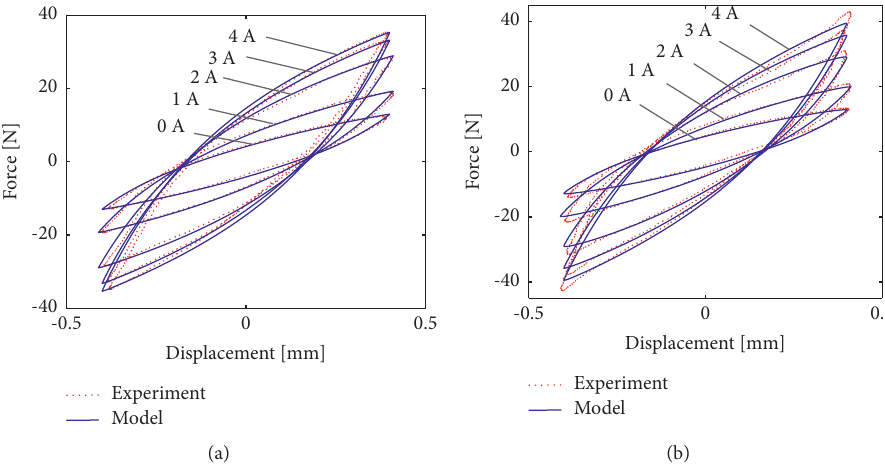
Figure 5: Force-displacement response under various applied currents ( I � 0A (0mT), 1A (109 mT), 2A (218mT), 3A (325 mT), and 4A (437 mT)): (a) f � 1 Hz and (b) f � 15